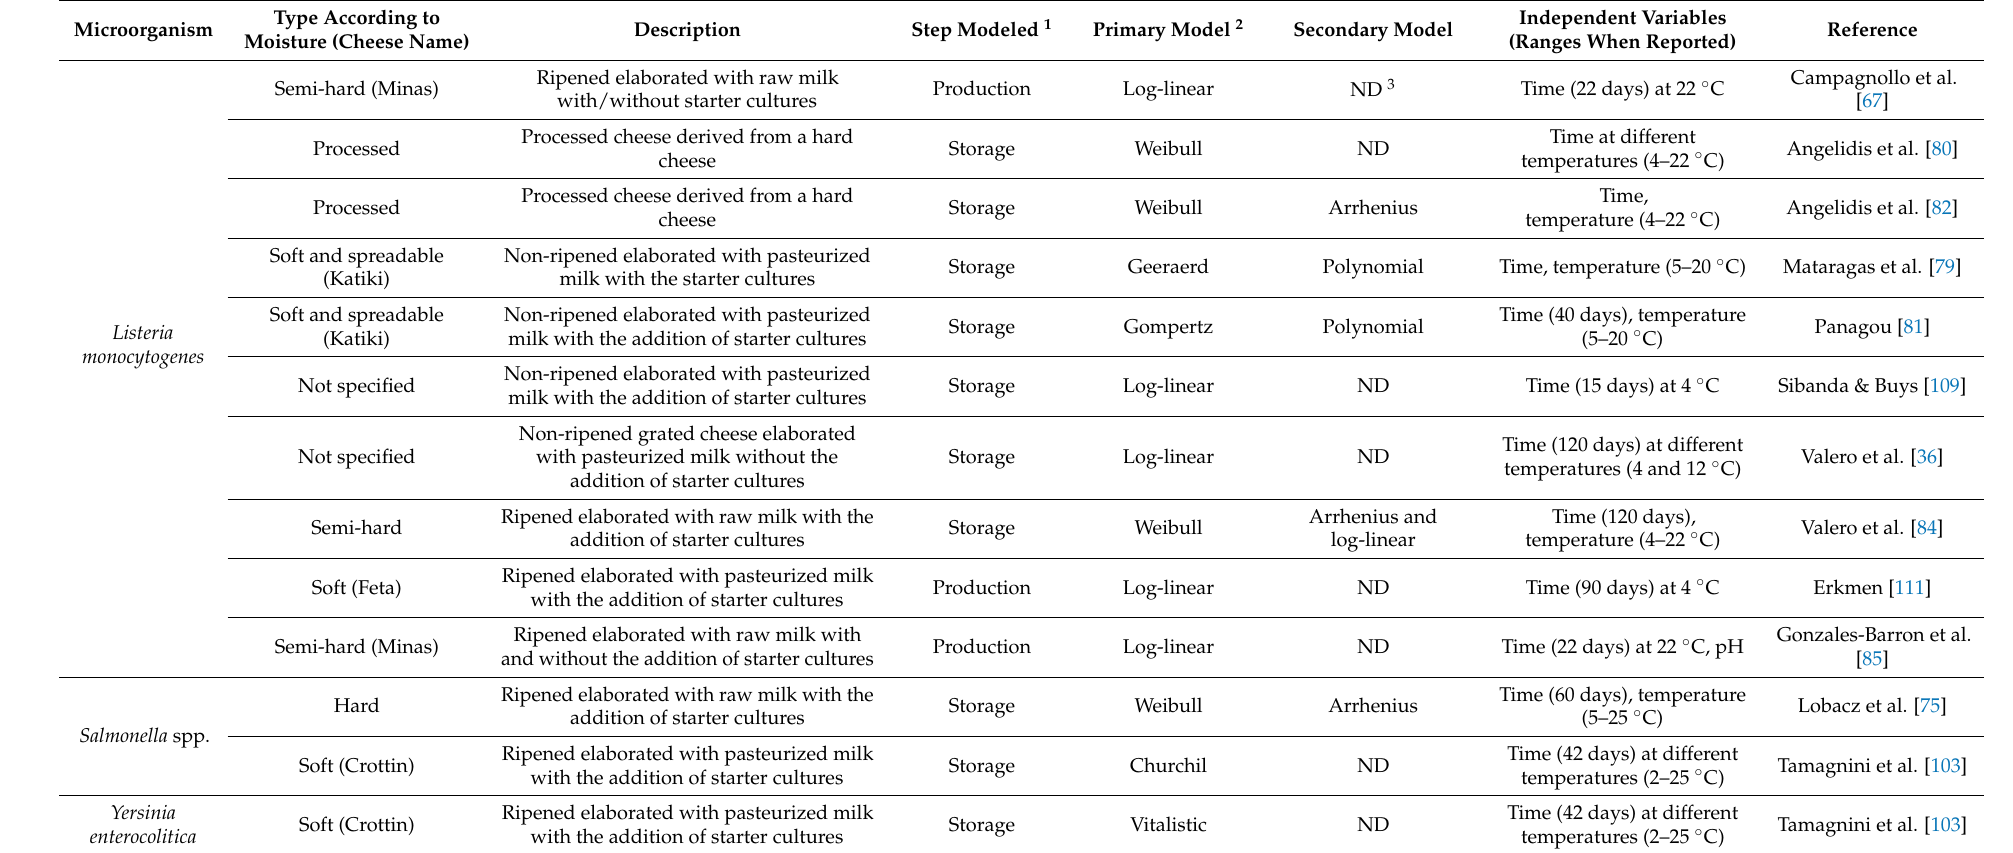
Table 2. Microbial primary and secondary survival models developed in